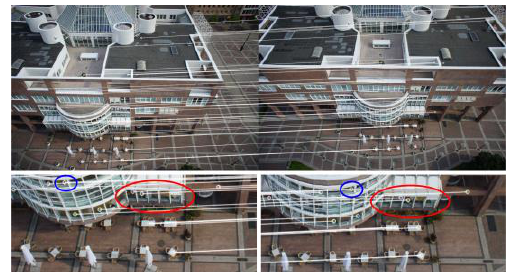
Figure 4. Image matching results between a pair of images; top: detected correspondences; bottom: details illustrating the remaining outliers, marked with red and blue ellipses